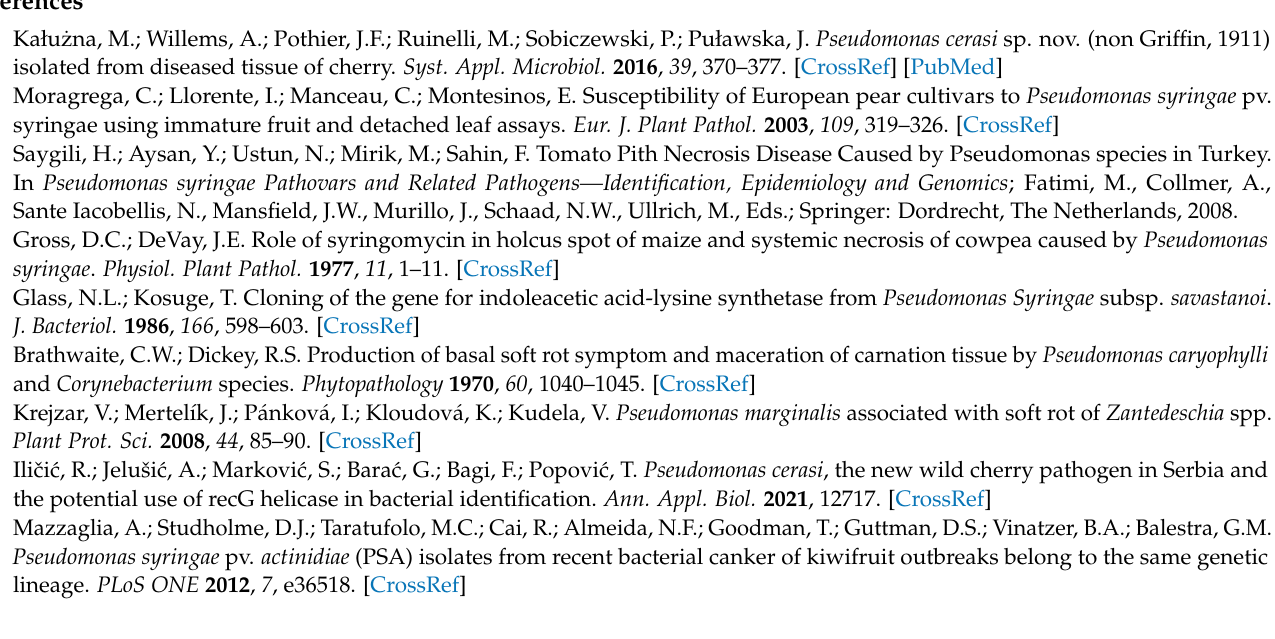
Figure S1: Transmission electron microscopy of the Pseudomonas phage Pf-10; Figure S2: Transmission electron microscopy of the Pseudomonas phage Pf-10; Table S2: Annotation of Pseudomonas phage Pf-10; Table S3: Primers used to locate the ends of the Pf-10 genome; Table S4: Large terminase subunit of Pf-10 and large terminase subunits of phages with well-known packaging mechanisms used for the phylogenetic tree; Figure S3: The pairwise whole-genome tBLASTx comparison of Pseudomonas phage Pf-10 and Enterobacteria phage T7 visualized with ViPTree server version 1.9; Table S5: Phage genomes used for phylogenetic inference; Figure S4: Restriction analysis of the phage genomic DNA; Figure S5: Schematic representation of the DTR-containing region of the Pf-10 genome after whole genome sequencing and genome